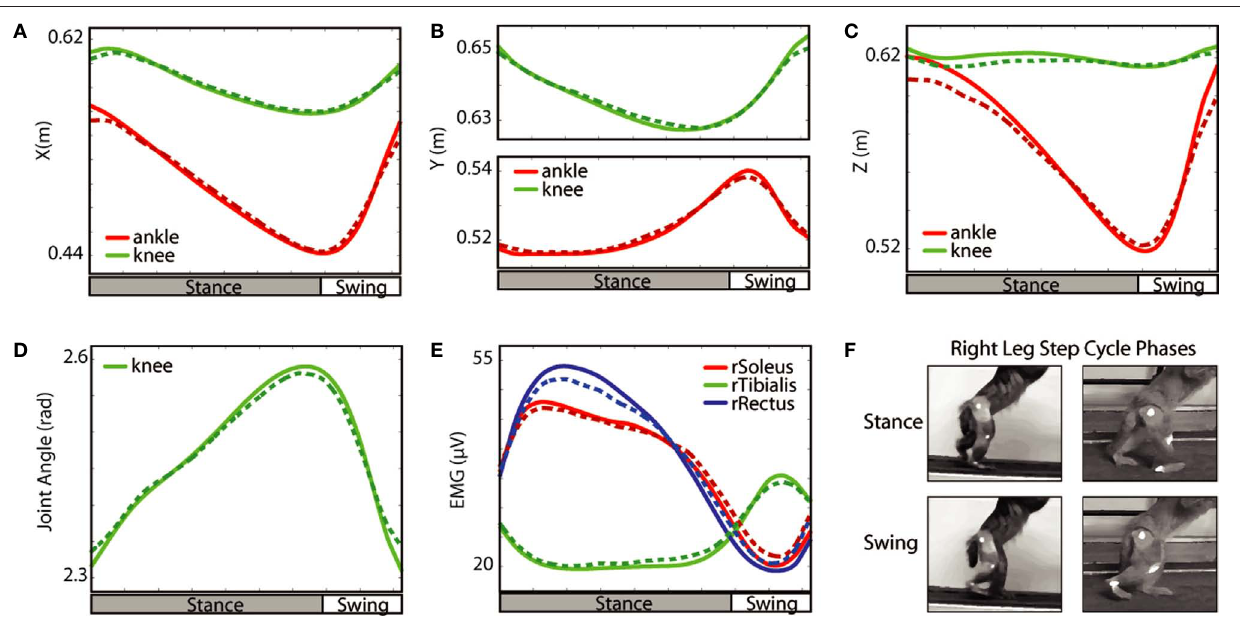
FIGURE 3 | Average changes in walking parameters during the step cycle. The data from all experimental sessions during which the monkey walked in forward direction with EMGs recorded were averaged. The average portions of the stance and swing phases of the step cycle are shown below each plot. The hip movements are not illustrated because they were small. Solid lines show the